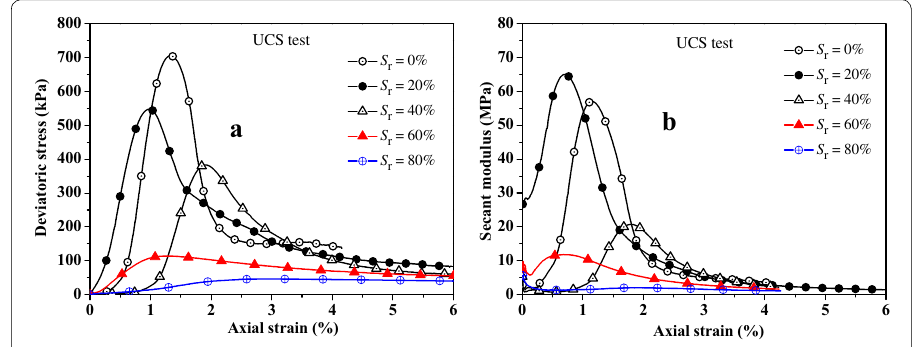
Fig. 10 Influence of S r on the response of cohesive RS subjected to UCS tests a stress–strain response, b strain-dependent secant modulus